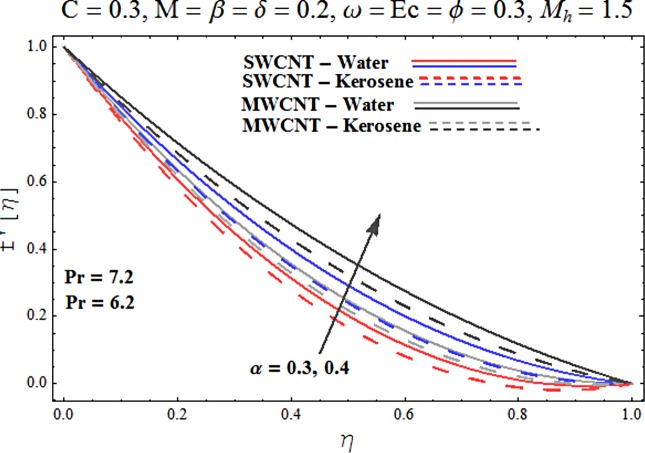
Effect of α on f′.